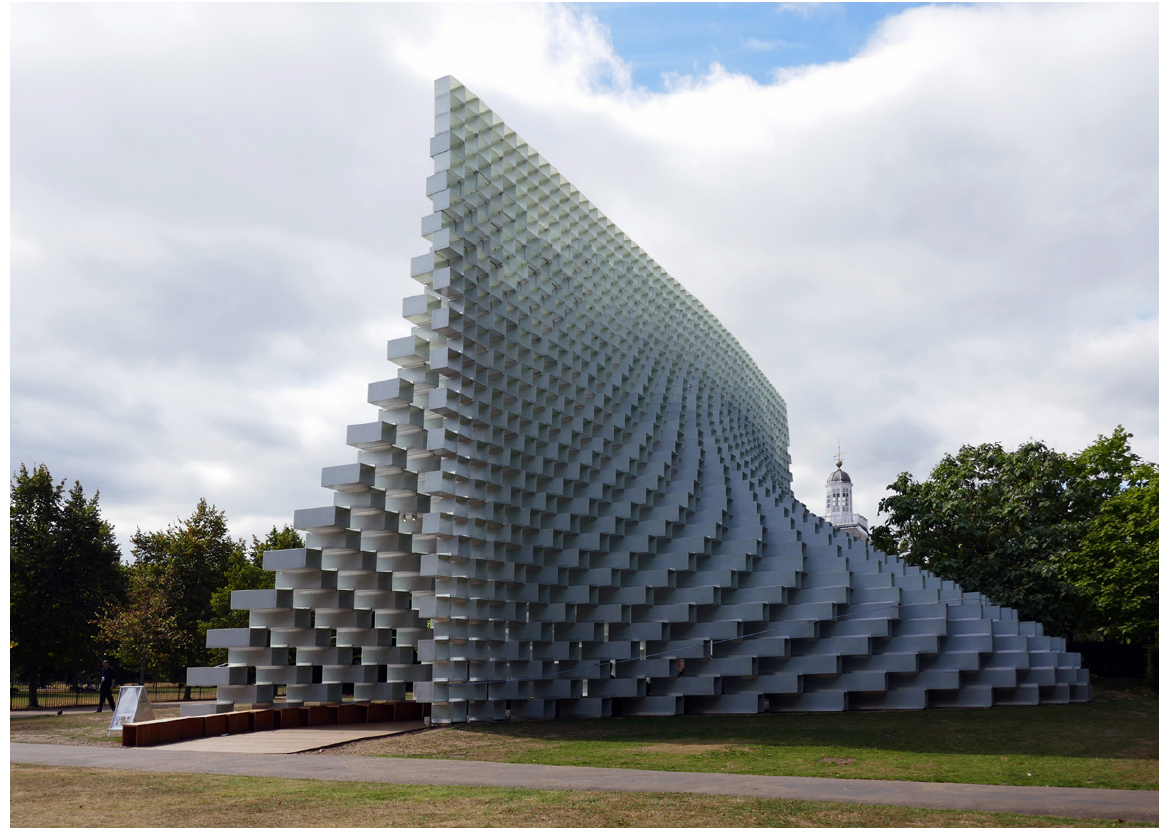
FIG. 1 Bjarke Ingels Group (BIG), 2016 Serpentine Pavilion, London. Source: Photograph by Ashley Paine,